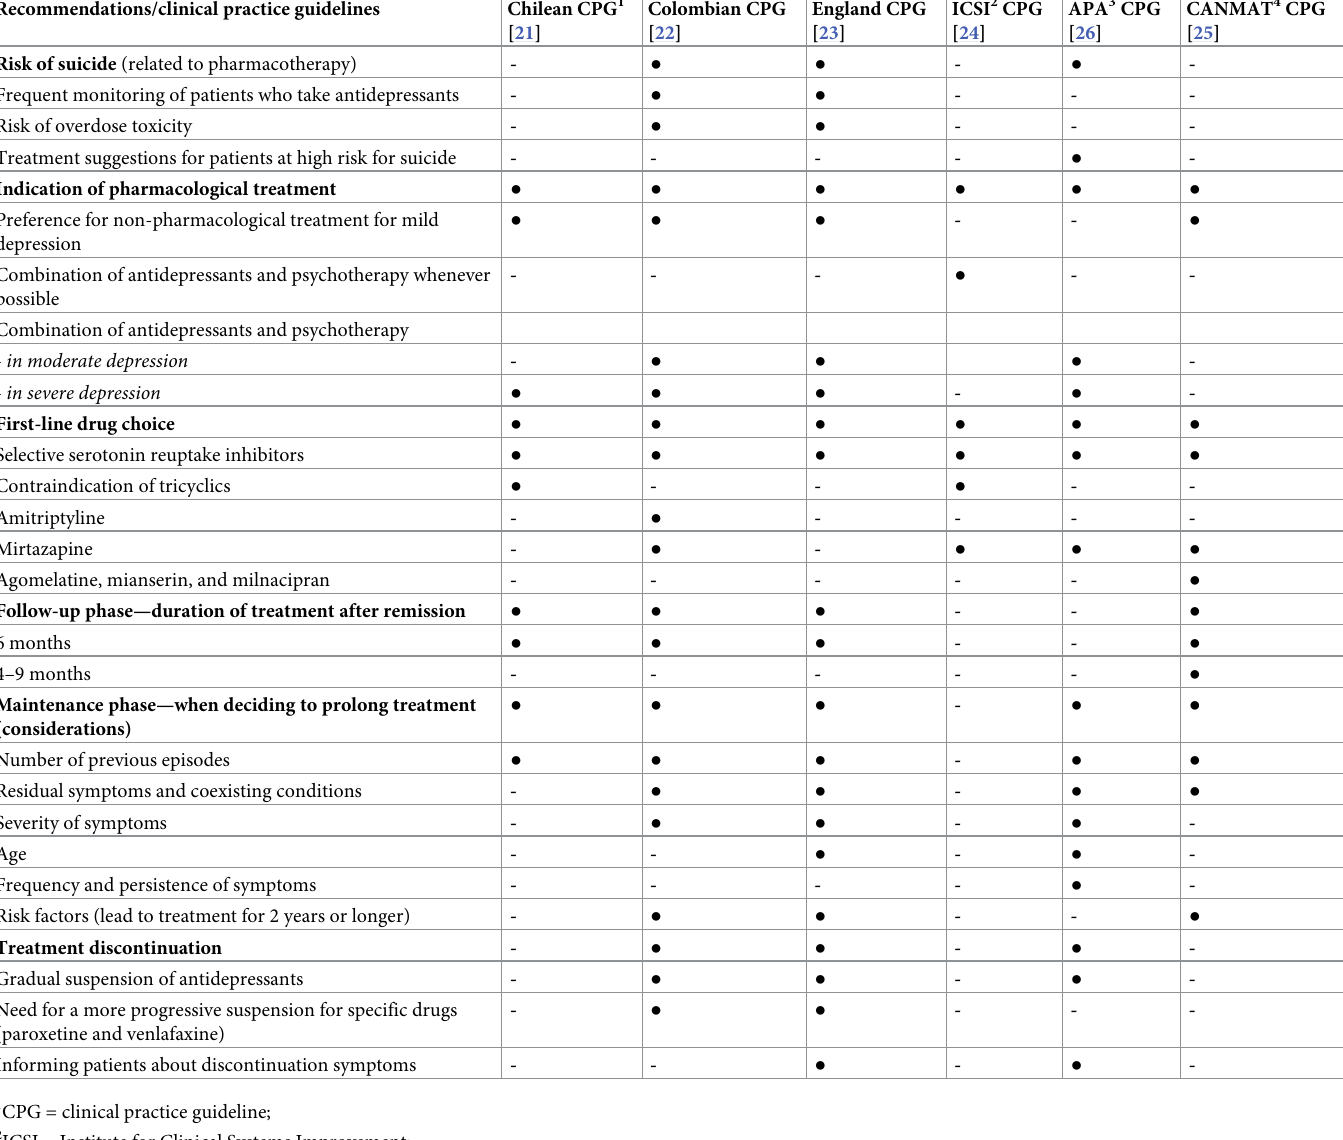
Table 2. Clinical practice guidelines for the pharmacological treatment of depression: